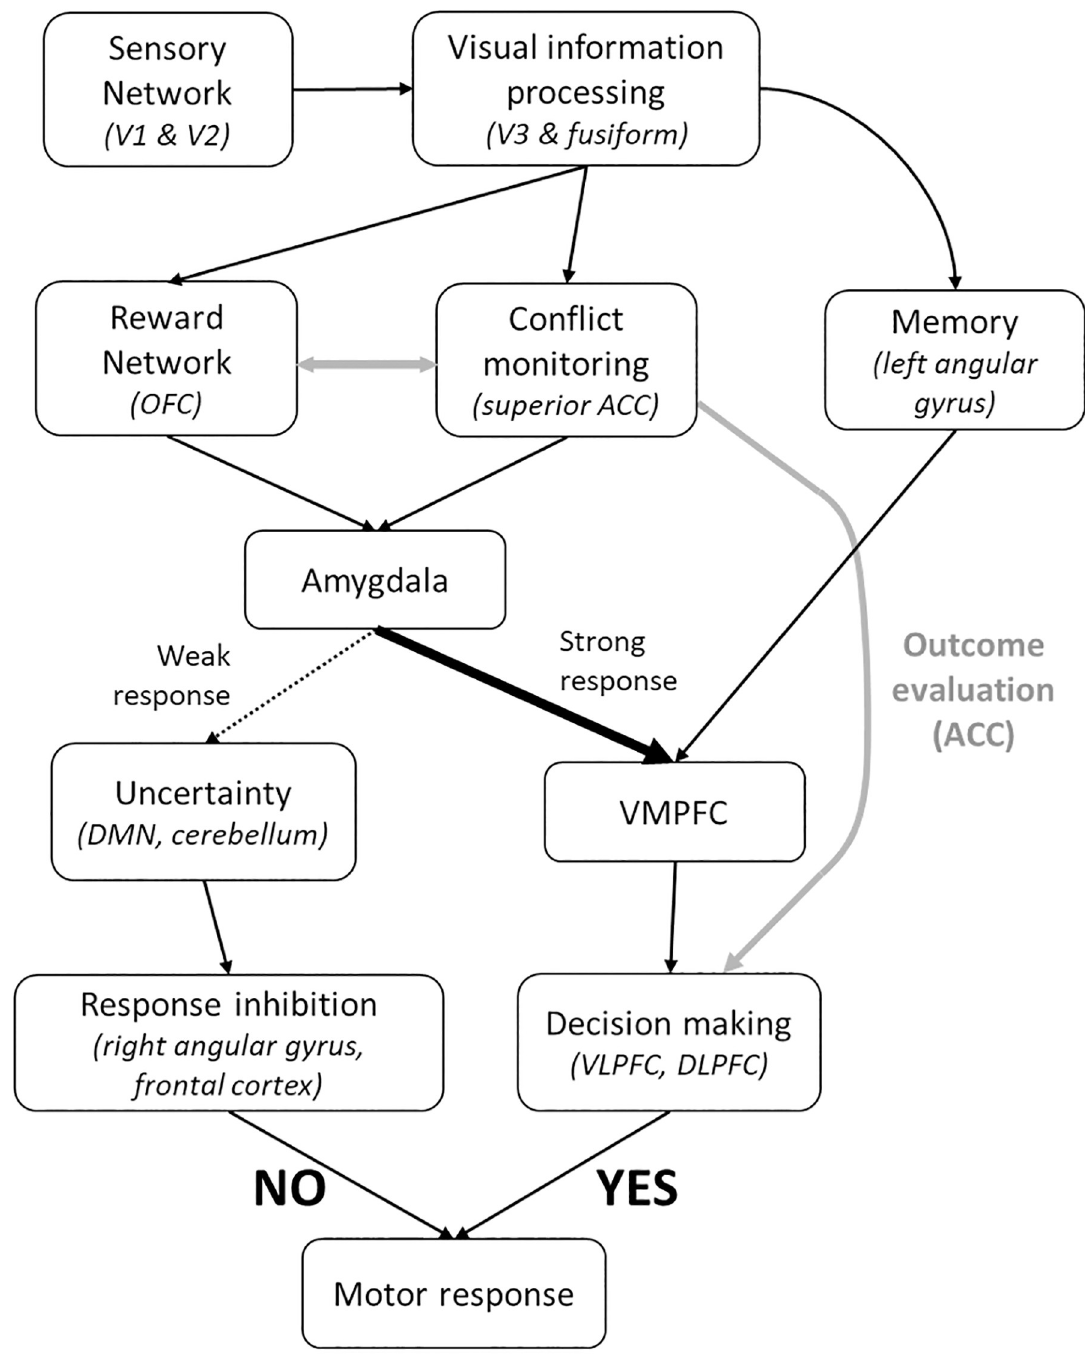
Fig 10. Summary of neurodynamic response model for app download decision making. Different boxes represent either different brain regions/ networks or region corresponding to different brain functions. The black arrows indicate communication between different brain regions. The direction of the arrow was inferred using concepts similar to Granger causality. Grey arrows indicate speculated communication between different brain regions. The dotted and the sold arrows going out of the Amygdala box indicate the relative strength of activation of the Amygdala (Dotted arrow–weak response and Solid thick arrow–strong response).